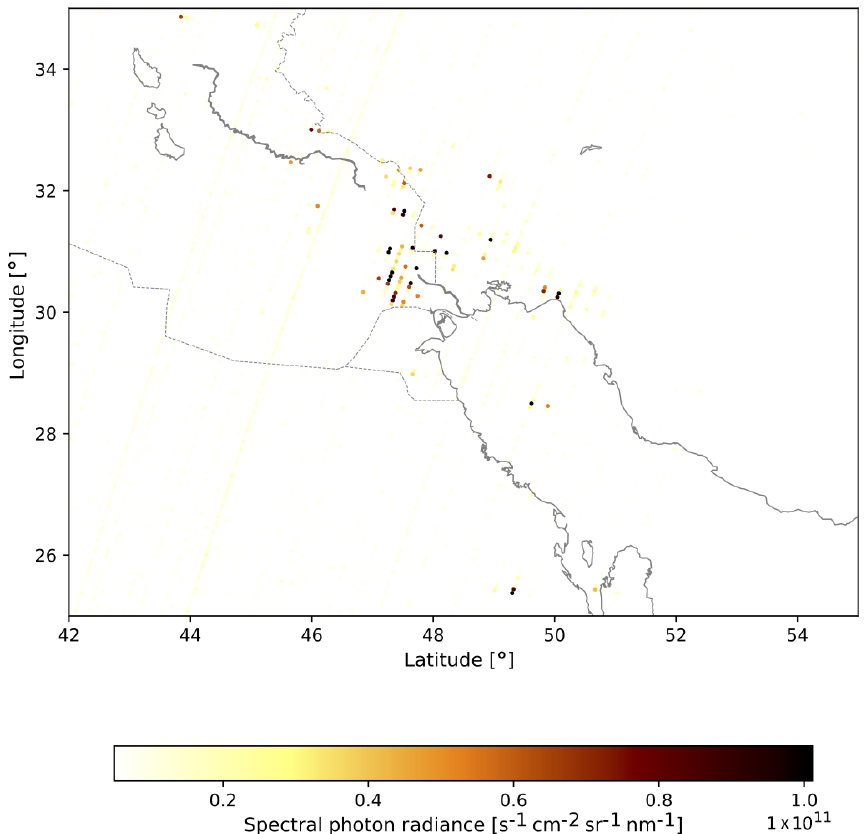
Figure 3. Continuum radiance at 2314nm on the eclipse side of the Earth around the Iraqi city of Basra. Any stripes in the figure are limitations of calibration and thermal stability at the time. Localized enhanced signals are clear indications of emission sources on